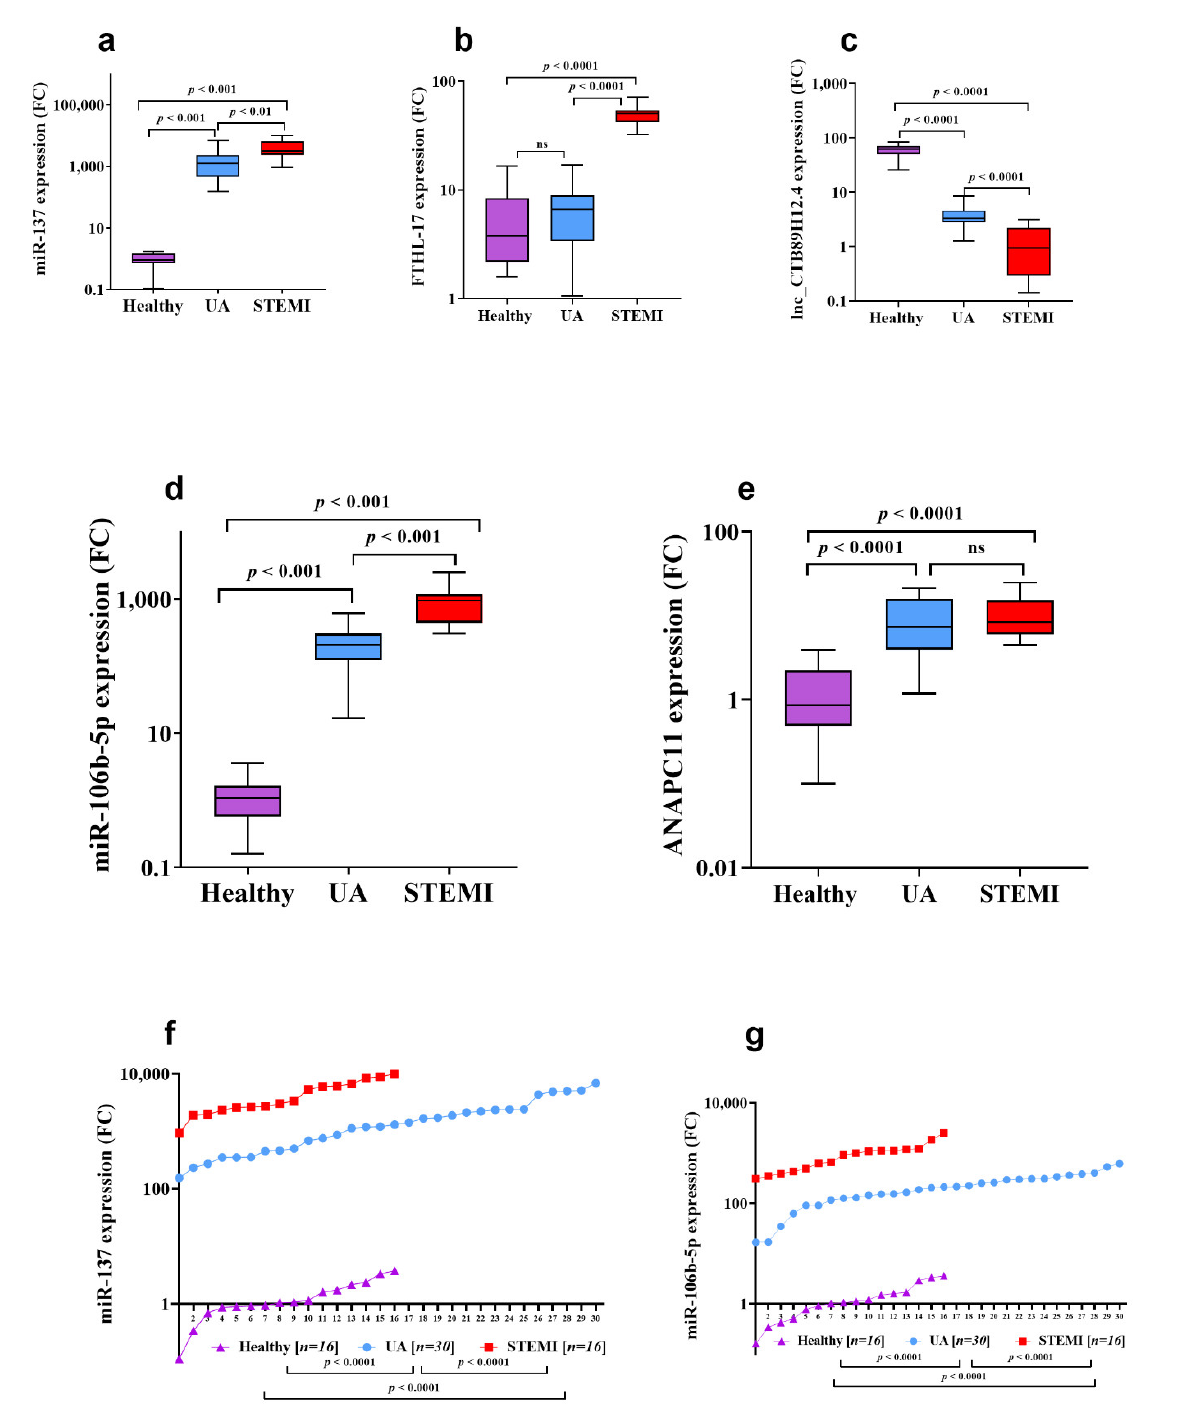
Figure 3. Expression profiles of candidate miRNAs in patients with UA and acute STEMI in comparison to healthy controls. The two candidate miRNAs, miR-137 and miR-106b-5p , were measured with qRT-PCR using 62 serum samples, including 16 Healthy (non-ACS) as well as 30 UA and 16 STEMI patients (ACS samples). miR-137 ( a ) and miR-106b-5p ( d ) were significantly upregulated in the UA and STEMI groups compared to Healthy ( a , d ). In addition, similar upregulation was observed for the associated mRNA targets FTHL-17 ( b ) and ANAPC11 ( e ), while the lnc-CTB89H12.4 regulating gene was significantly decreased in UA and STEMI patients ( c ). ( f , g ) demonstrate the expression pattern of miR-137 and miR-106b-5p in the three studied groups (UA, STEMI and Healthy). Abbreviation: ns: no significant difference.